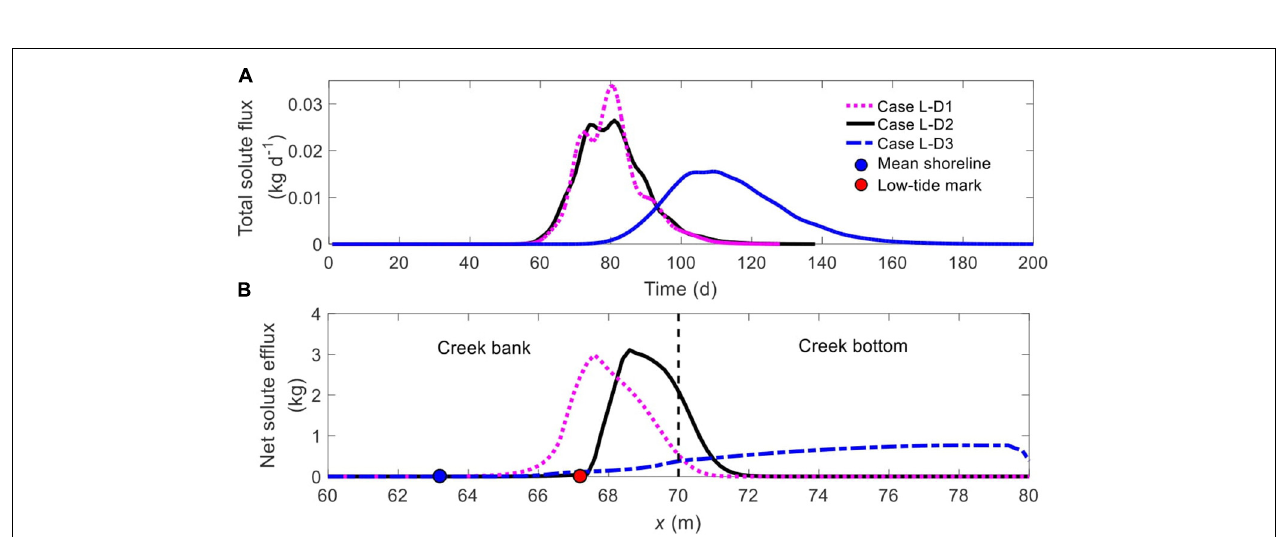
FIGURE 11 | Comparison of (A) time-dependent total solute efflux and (B) spatial distribution of net solute efflux across the SWI (BCDE in Figure 1 ) for different D mud . The blue and red nodes in panel (B) represent the mean shoreline and low-tide mark, respectively, while the vertical dashed line separates creek bank (left) and creek bottom (right).